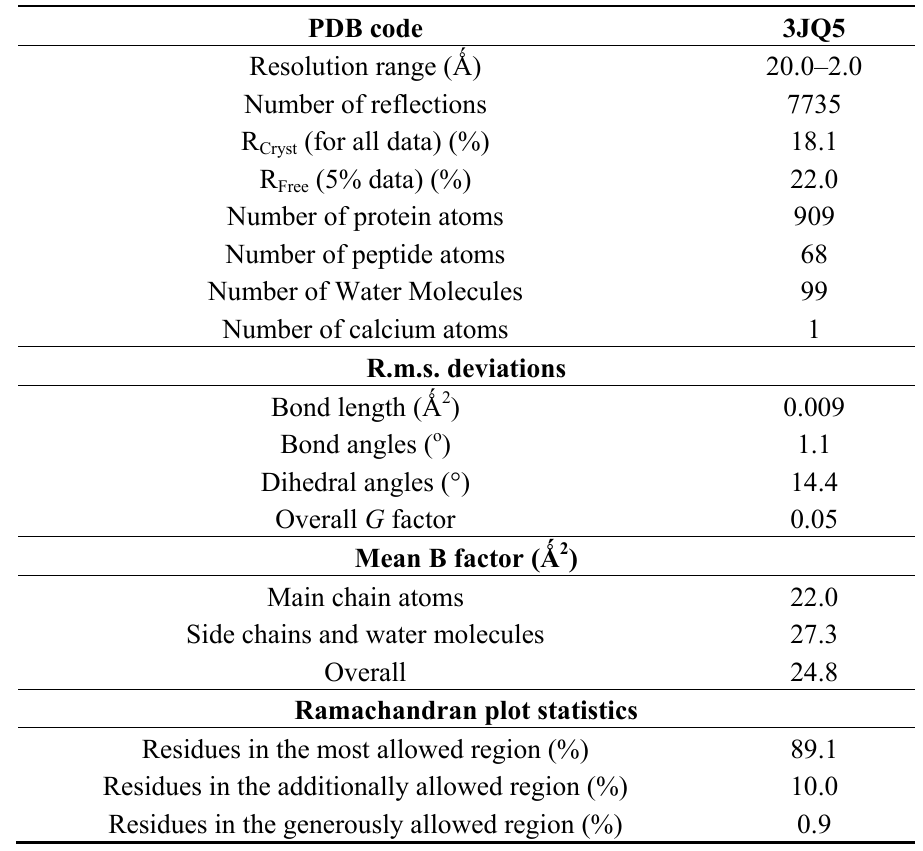
: helical segment is 2